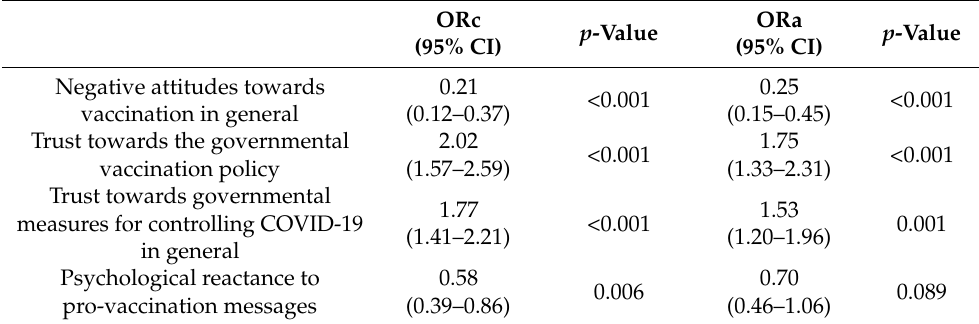
Table 3. Factors associated with COVID-19 vaccine booster dose uptake ( n = 264).